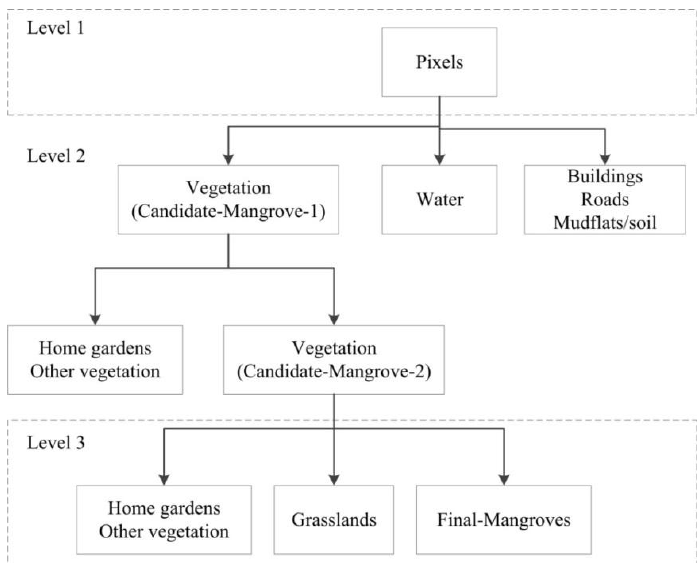
Figure 3. The schematic explanation of image objects at different hierarchical levels. The first level was at pixel level. At the second level: vegetation and non-vegetation areas were identified. Mangrove areas were extracted at the final